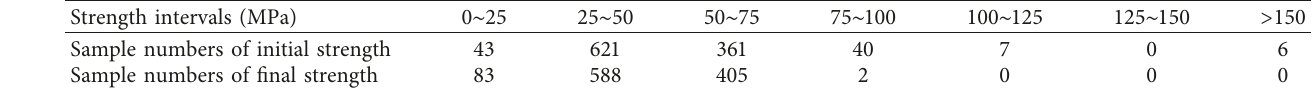
Table 3: Sample numbers of initial and final strength distribution intervals.